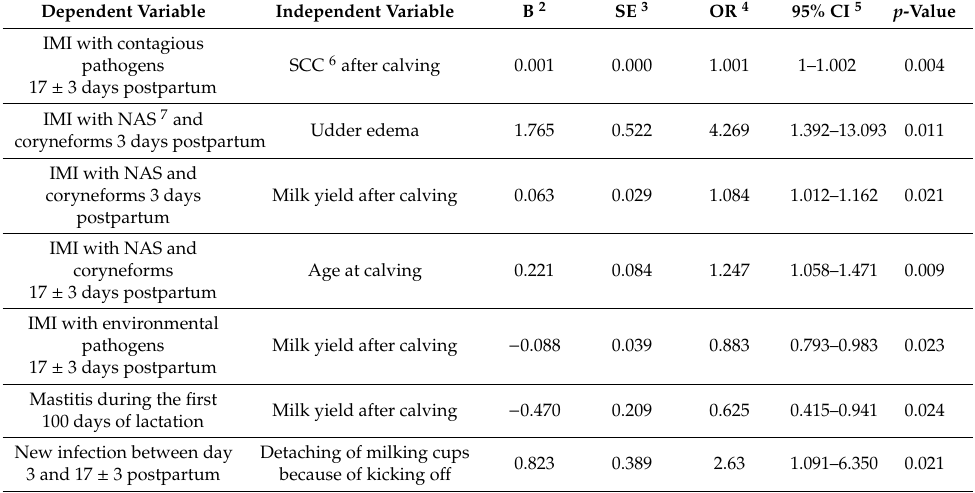
Table 5. Final logistic regression models for the probability of a quarter to develop an IMI 1 or clinical mastitis, shown as the association between dependent and independent